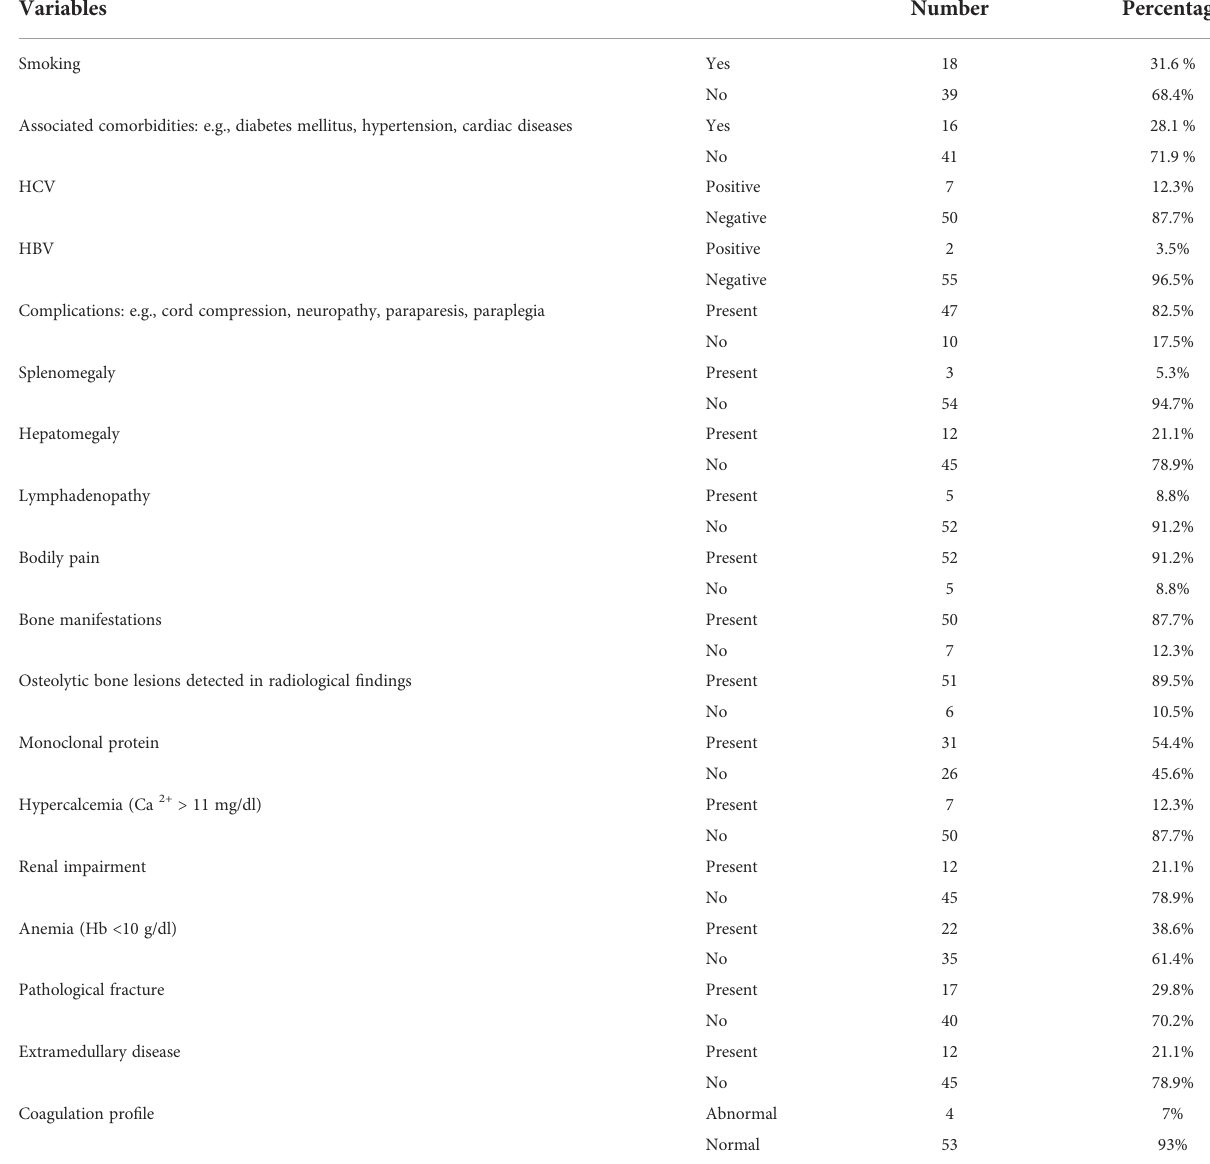
TABLE 3 Descriptive and clinical characteristics of the MM patients at diagnosis.